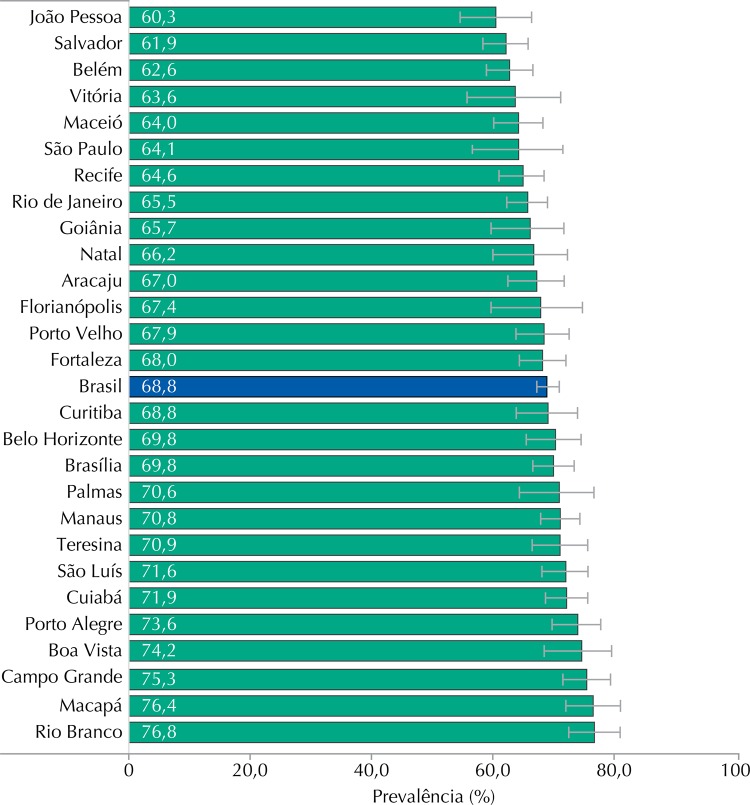
Prevalência de uso de preservativo masculino na última relação sexual, segundo as capitais. ERICA, Brasil, 2013-2014.